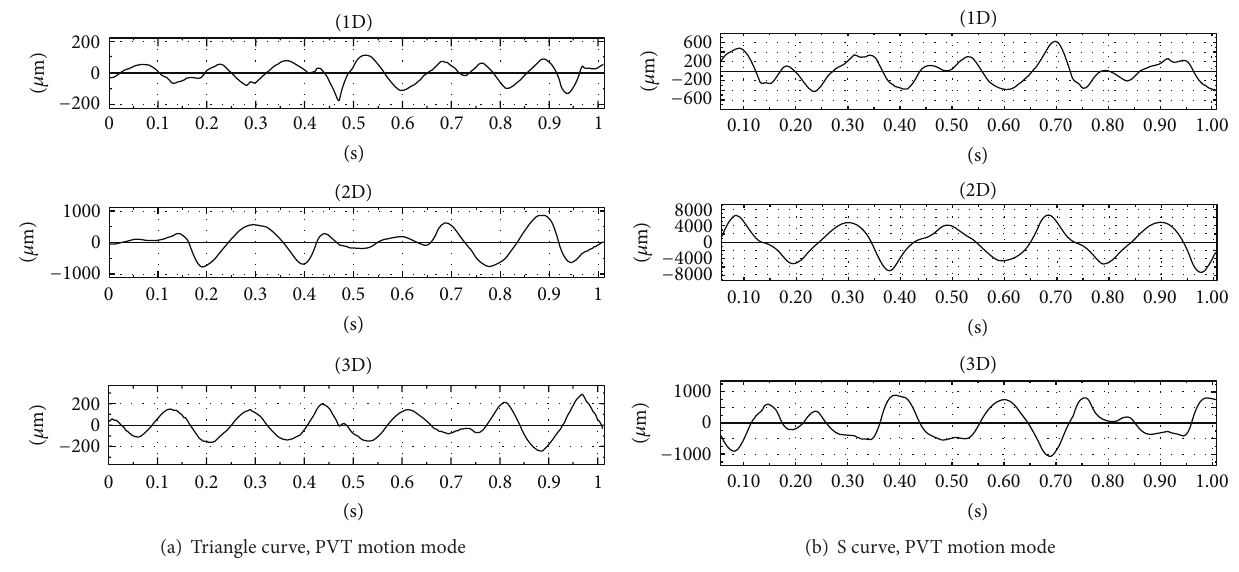
Figure 9: Vibration amplitude distribution in the time domain of the x- , y- , and z -axis.